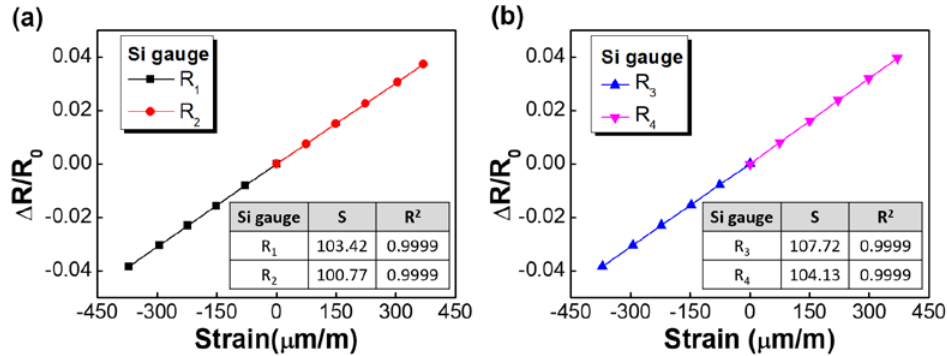
Figure 8. Strain sensitivities of the Si strain gauges fabricated on alkali-glass substrate. ( a ) R 1 and R 2 , ( b ) R 3 and R 4 . (The insets summarize the typical sensitivities and linear correlation coe ffi